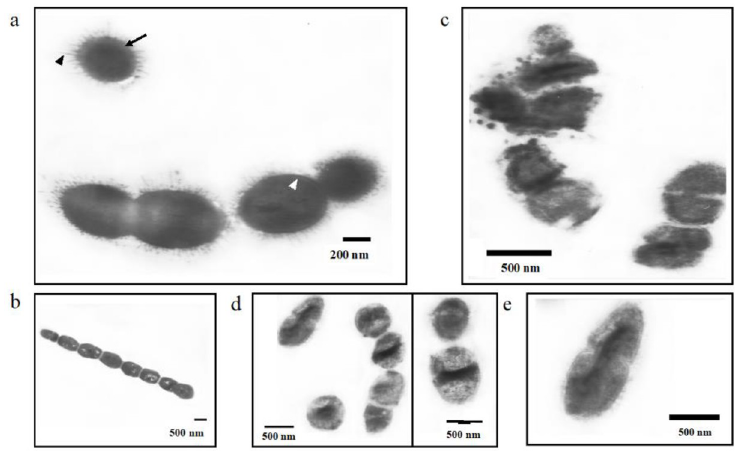
Fig 5. Ultrastructure changes of S . pneumoniae affected by L . inermis extract. a) untreated S . pneumoniae showing normal ultrastructure of S . pneumoniae . b-e) treated S . pneumoniae with L . inermis extract showing various ultrastructure disorder on S . pneumoniae . Prior to sample block preparation for TEM, the pathogen (1 McFarland) was incubated with 2 × MIC of L . inermis ethyl acetate extract for 2 hours. The cells were then fixed with 2,5% glutaraldehyde. Cells were blocked in Spurr’s resin. Ultrastructure changes were observed under 8000–12000 magnification. Black triangle: pilus structure, black arrow head: capsule, white arrow: cell wall.